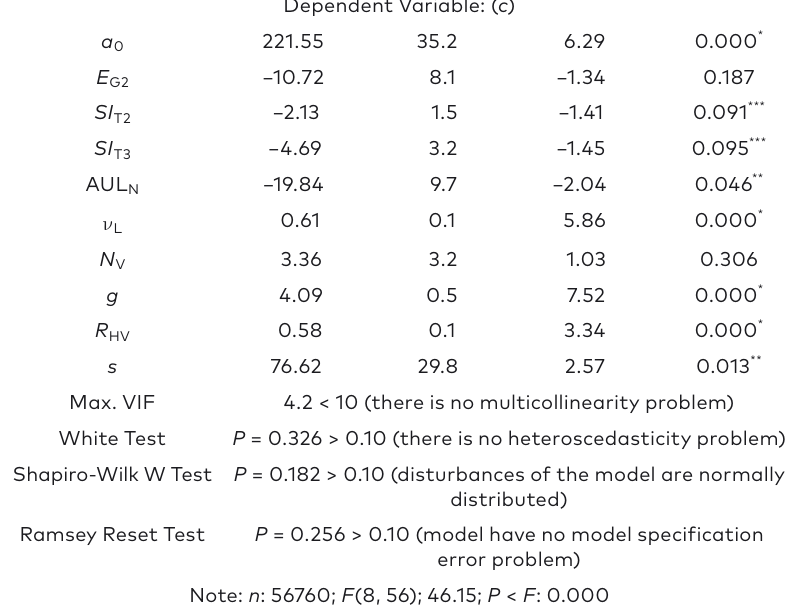
intersection legs